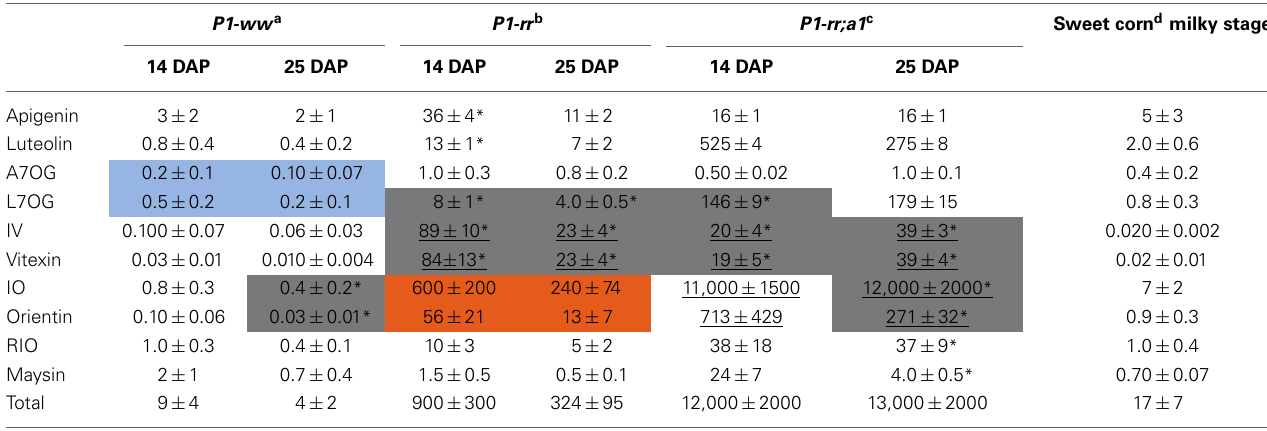
Table 2 | Flavone content in hydrolyzed whole maize kernel. P1-ww